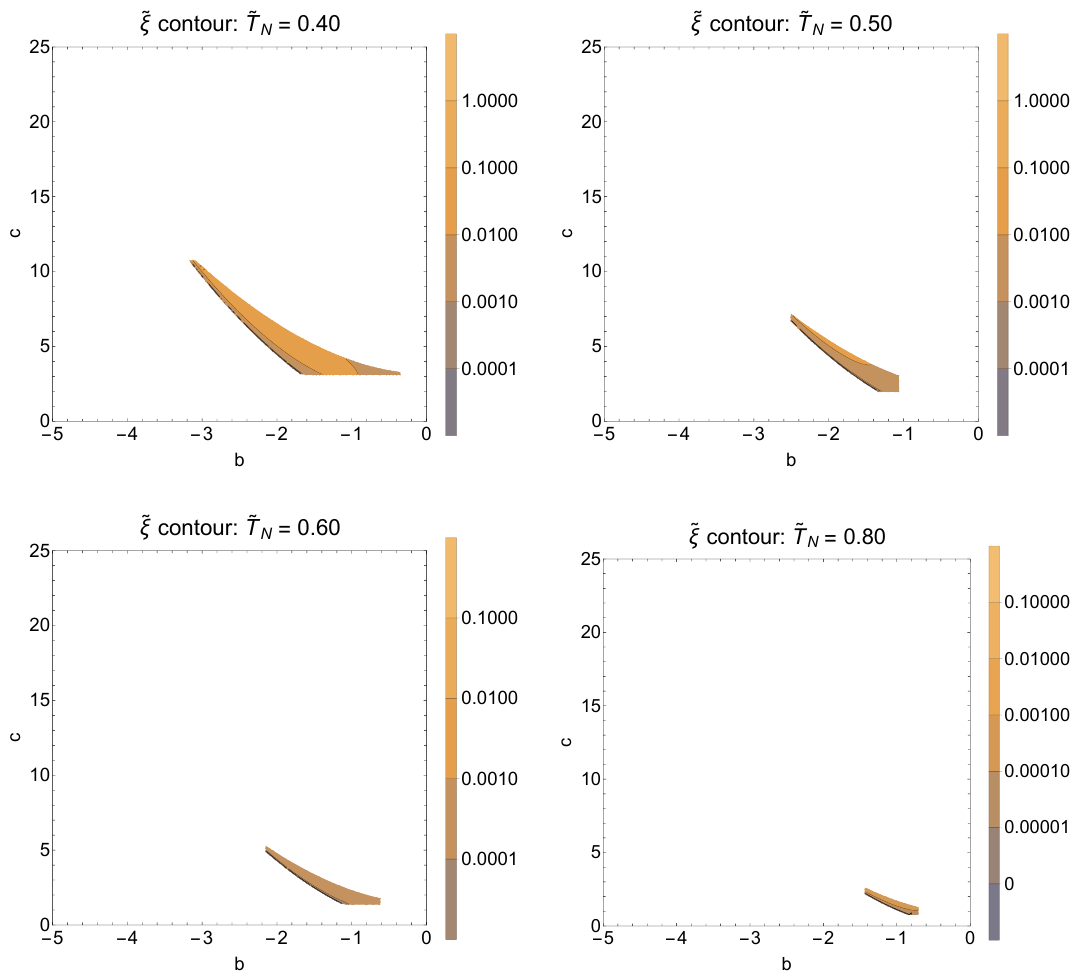
˜ Figure 6. Contours of ξ are shown in the ( b, c ) plane for the allowed parameter space for higher values of ˜ T : ˜ T = 0 . 40 (upper left), 0 . 50 (upper right), 0 . 60 (lower left), and 0 . 80 (lower right). N N The contours also satisfy the conditions: c ≥ b 2 , c ˜ T ˜ ˜ ˜ ˜ β/H ≥ S E / 140 T N and ξ ≥ 0